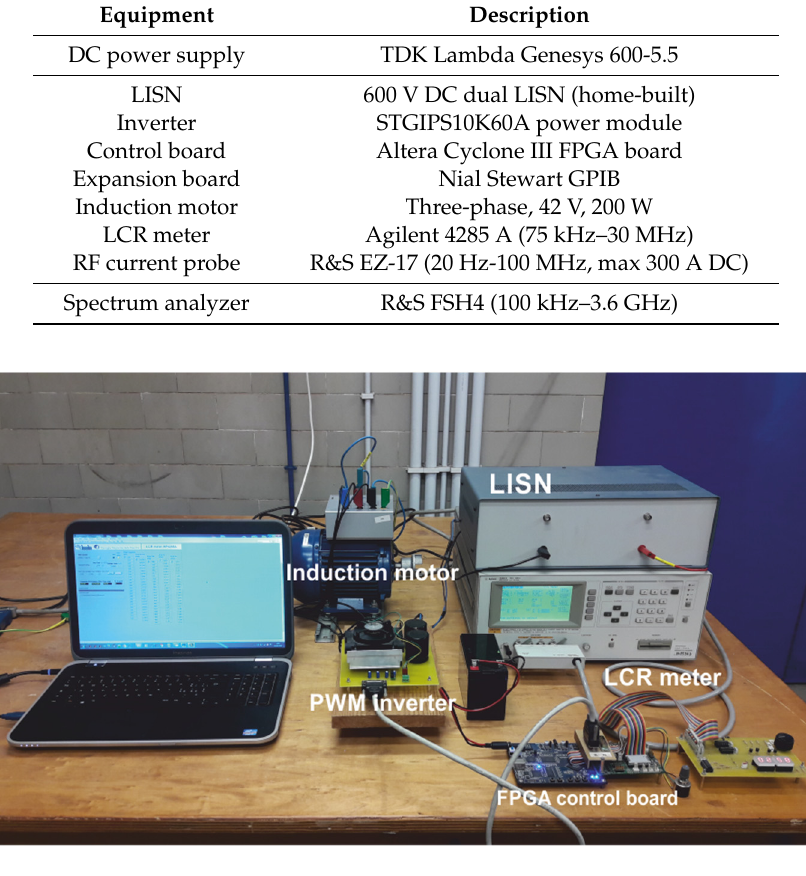
Figure 4. Photo of the experimental setup.